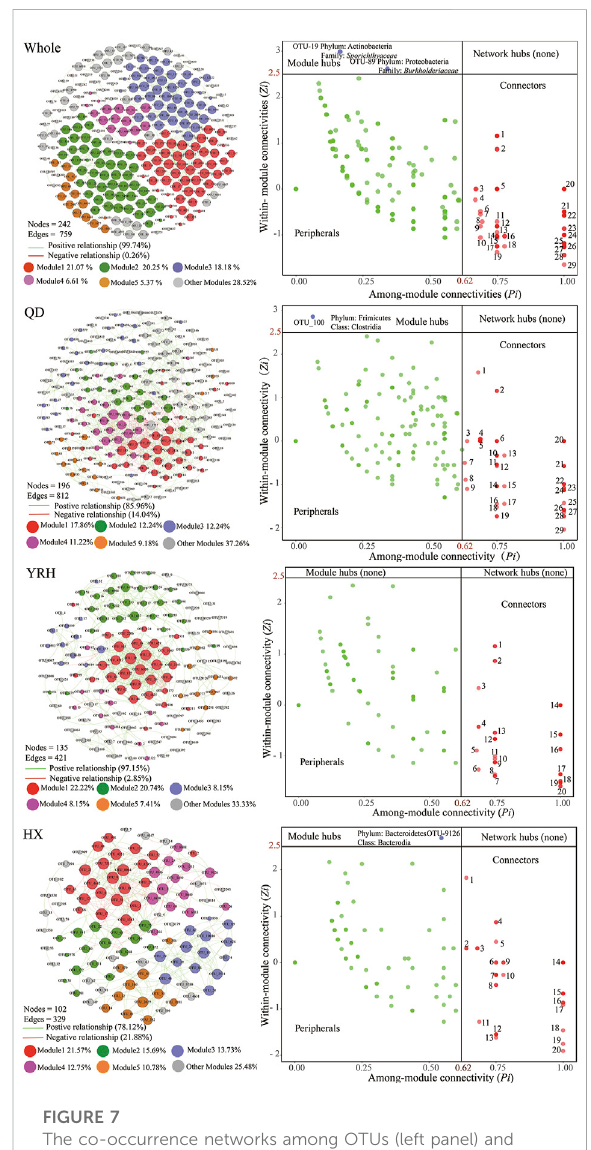
FIGURE 7 The co-occurrence networks among OTUs (left panel) and Zi-Pi plot showing the distribution of OTUs (right panel) in the whole and the three regions based on Spearman ’ s rank correlations (r > 0.8 or r < − 0.8 p < 0.01) and their topological roles, respectively. The size of each node is proportional to the number of connections (i.e., degree), and the nodes are colored according to different types of modularity classes. Each node represents an OTU. Edges with green or red colors represent positive or negative relationship between any two